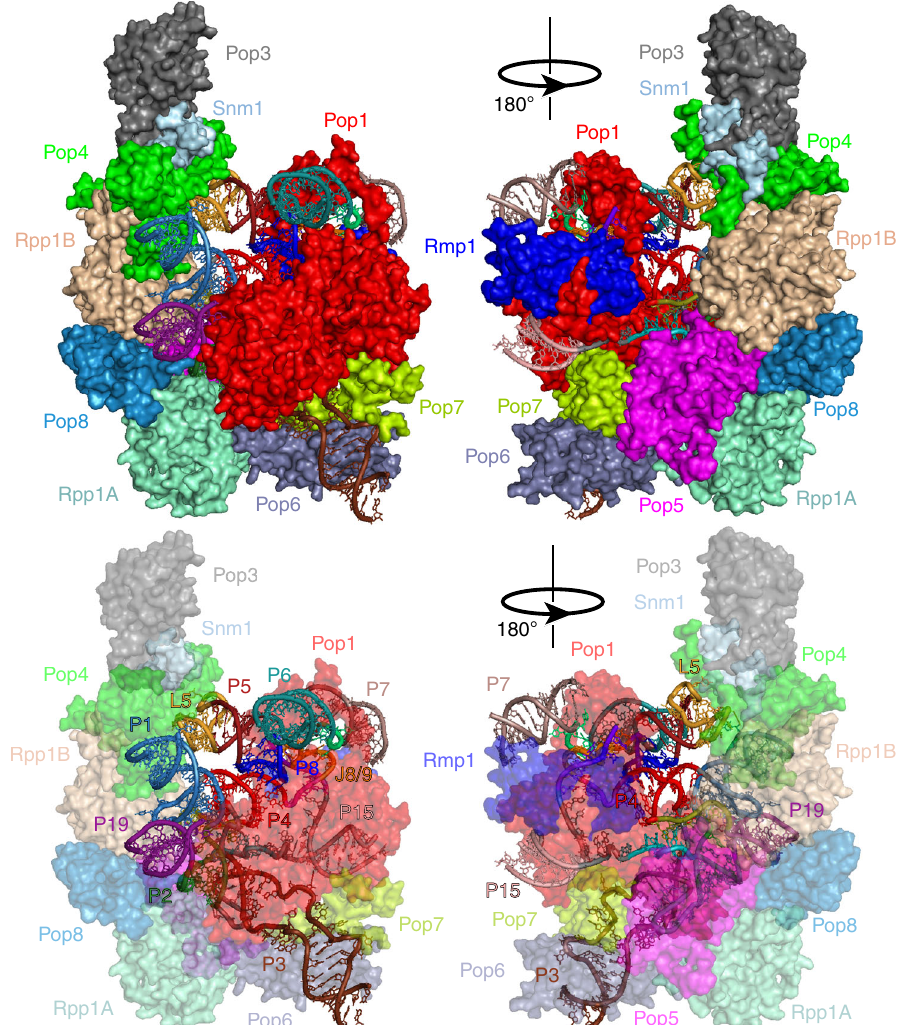
Fig. 2 Structure of the RNase MRP holoenzyme. Protein components (shown as surfaces) are color coded as marked; the RNA elements (shown as a cartoon) are color coded according to Fig.